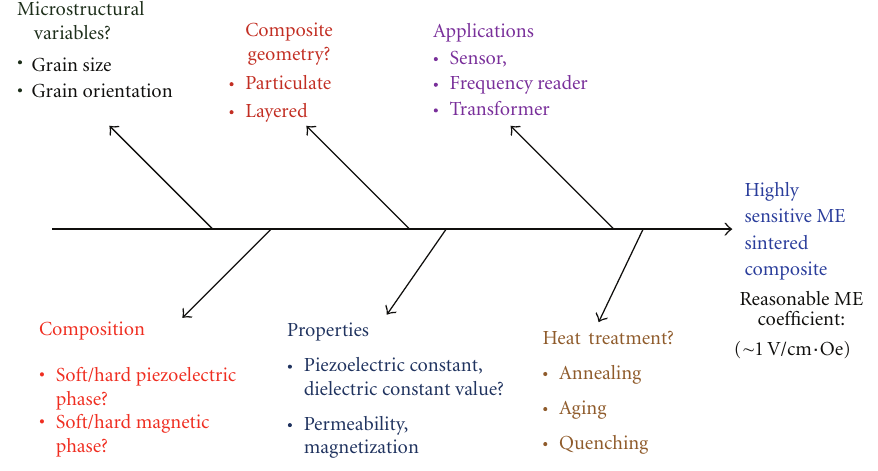
Figure 4: Fish-bone diagram for solving ME sintered composite